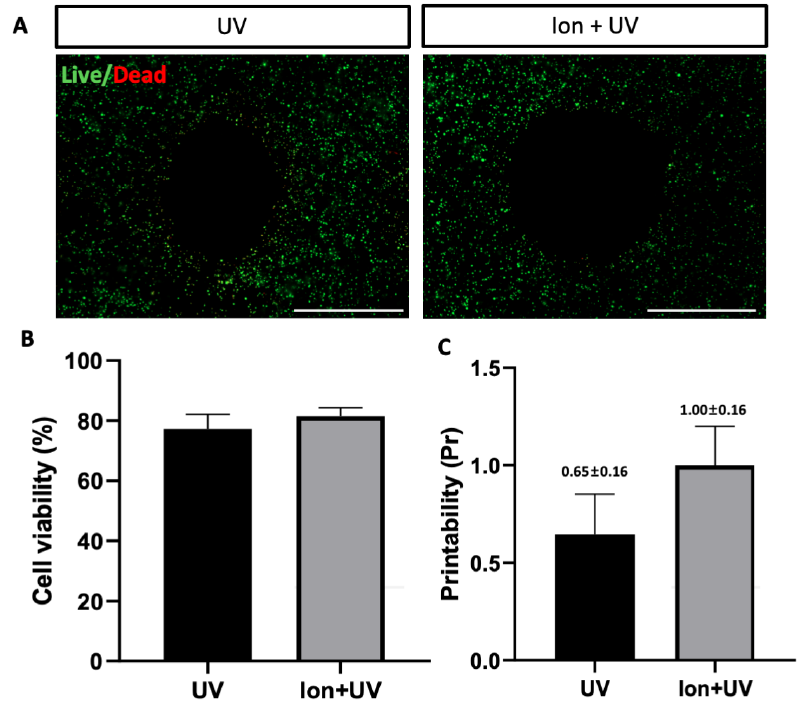
Figure 8. Cell viability of 3D-bioprinted hMSCs. ( A ) Fluorescence micrograph of Live/Dead assay for printed fiber. Bioink composition was 10:2:2:2 (GelMA:alginate:CMC:XG) and cross-linking conditions were UV and ion + UV. ( B ) Cell viability results of 3D-encapsulated cell in printed fiber (UV vs. ion + UV). ( C ) Printability (Pr) of printed fiber after 24 h (scale bar = 100×, 200 μm).